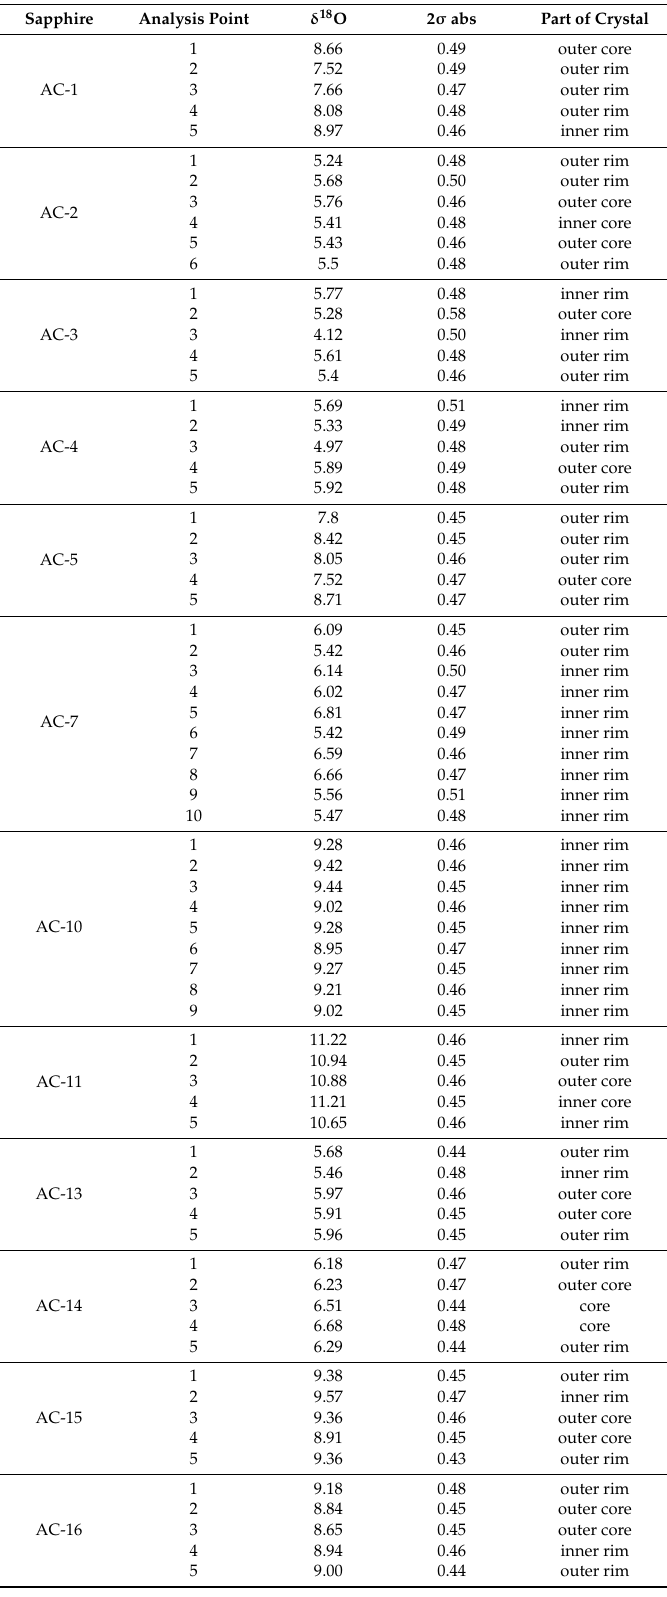
Table 2. δ 18 O oxygen isotope results for grains AC-1 to AC-5, and AC-7, AC-10 to AC-11, AC-13 to